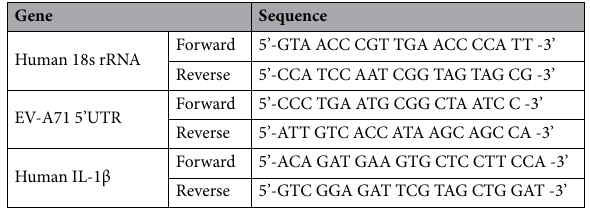
Table 1. qPCR primer used in this